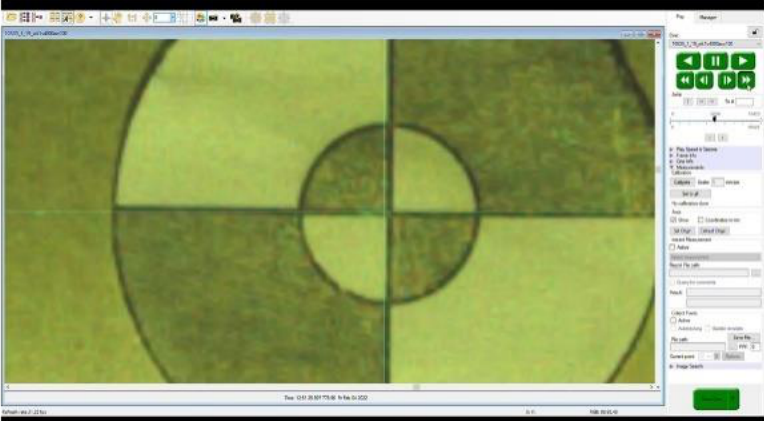
Figure 21. Measurement of the horizontal displacement of the marker for the parameters V4000 and ACC100. Results: d = 0.4744 mm; s = 0.0004 m/s; a = 0.4636 rad; as = 0.3627 rad/s.